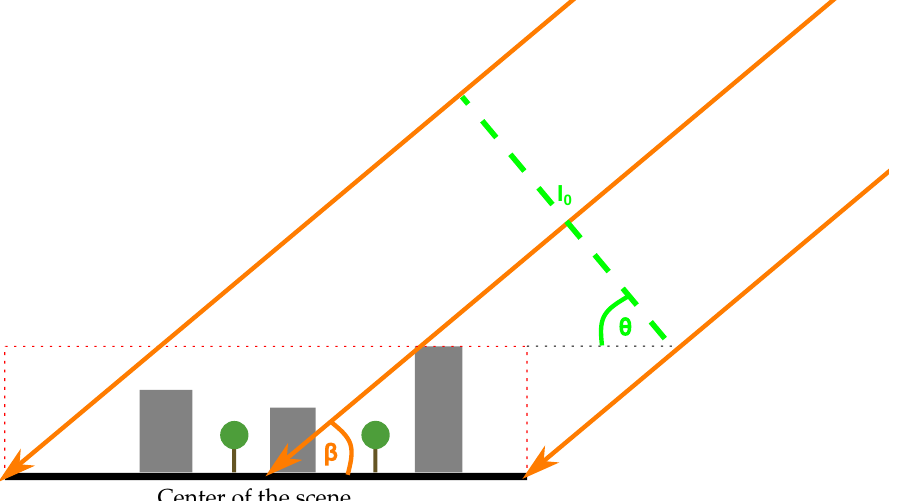
Figure 1. Sun rays are incident in parallel for given solar altitude angle ( β , °), depending on daytime and day of year. The flux density of these parallel beams (orange) to an orthogonal surface is I 0 (Wm − 2 ). The flux density on a surface I 0 is in relation to by the Lambert’s cosine law Equation (1) (modified after the work in [9], p.